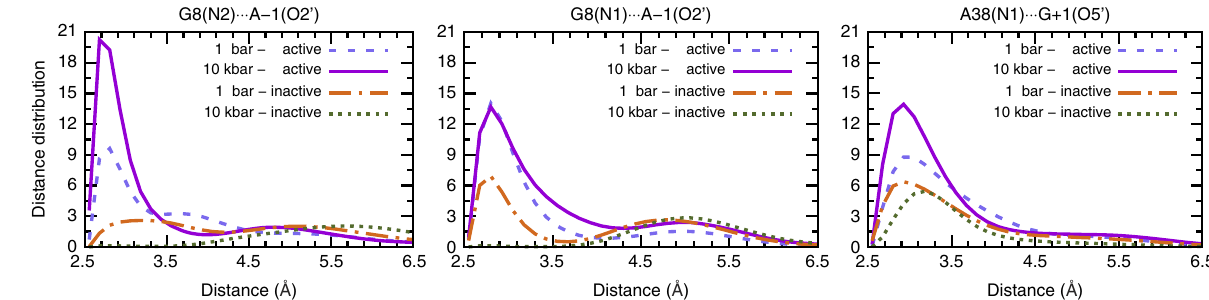
Figure 7 | Pressure enhances the H-bond interactions of G8 and A38. Probability distribution functions of relevant interatomic distances (see Fig. 2b) involving H-bond donors of the G8 and A38 nucleobases and the attacking as well as leaving groups of the transesterification cleavage reaction being the H-bond acceptors (that is, O2’ and O5’) separated into active and inactive configurations of the AP state (see text) at 1 bar and 10kbar at 300K. Stabilizing H-bond interactions occur for distances of roughly 2.8Å, which leads into maintaining the in-line configuration.